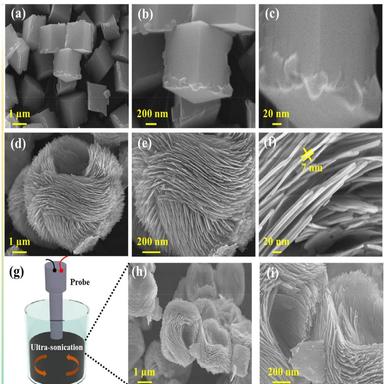
Morphological properties of the as-prepared flower-like FS nanostructure. Low- and high-magnification FE-SEM images of the as-prepared flower-like FS nanostructure before (a–c) and after calcination (d–f), respectively. (g–i) Structural stability of the as-prepared flower-like FS nanostructure after ultra-sonication treatment.